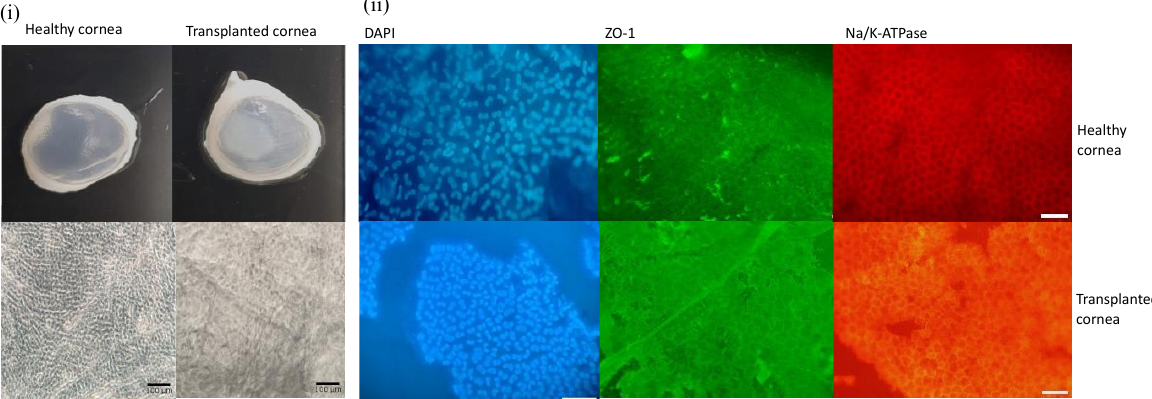
Figure 9. ( i ) Macroscopic view of representative healthy and transplanted corneas and phase contrast microscopy showing corneal endothelium. Scale bar = 100 μ m. ( ii ) Immunocytochemistry analysis showing the presence of the ZO-1 and Na/k-ATPase markers in the corneal endothelium of a healthy and transplanted cornea. Scale bar = 20 μ m.